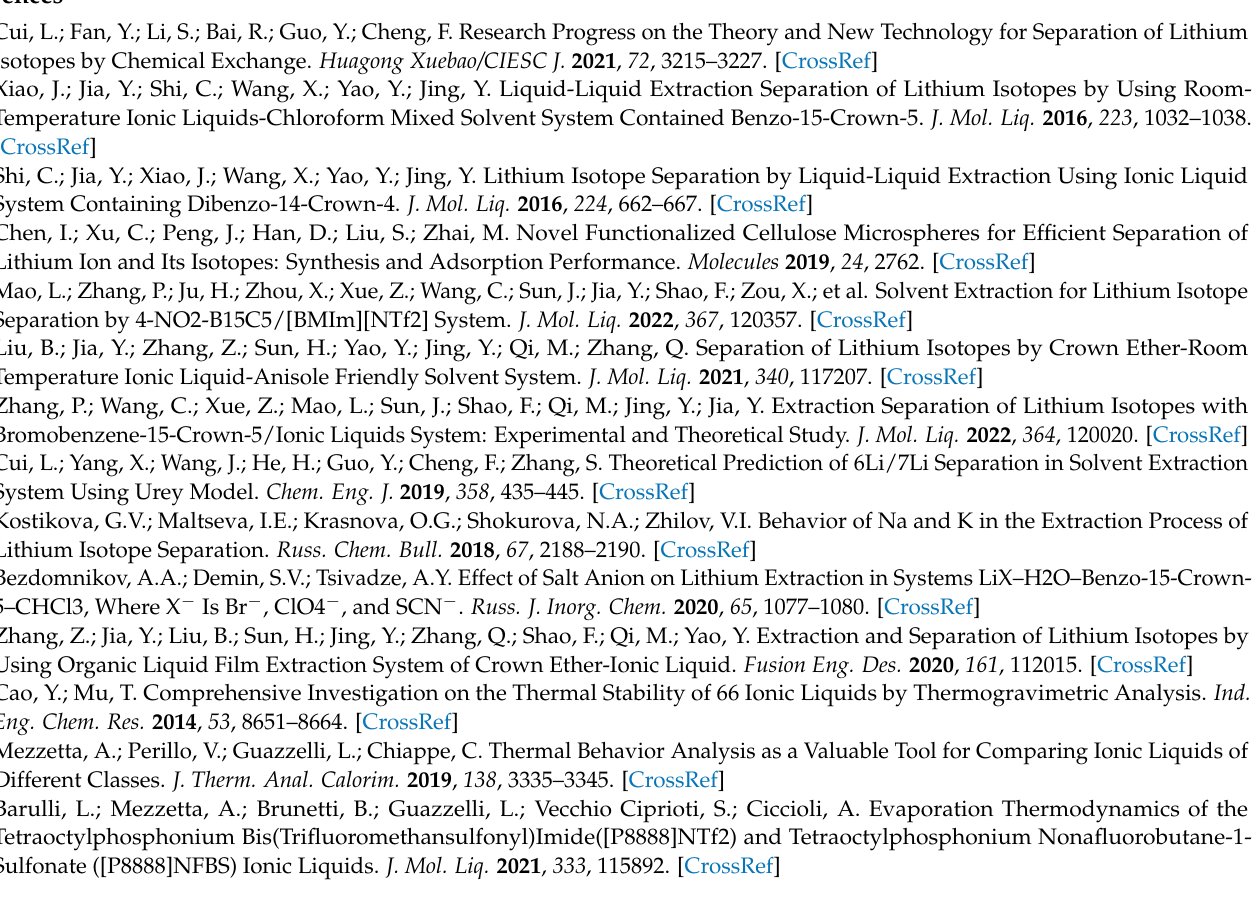
Table S1: The results of the synthesis of complexes